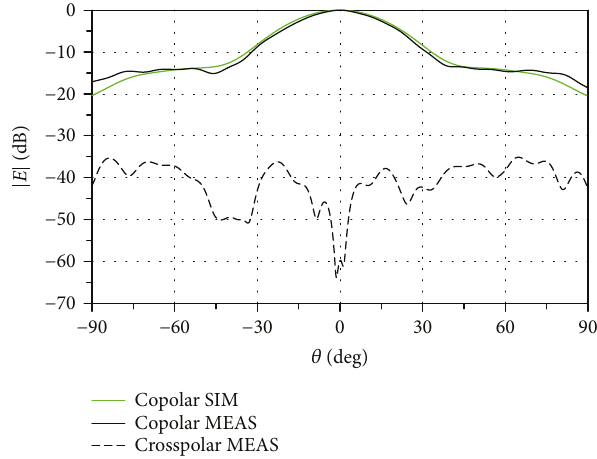
Figure 10: Normalized electric fi eld radiation pattern in the H - plane of the proposed lens antenna at 10GHz: simulated (SIM) and measured (MEAS) copolar and crosspolar components.